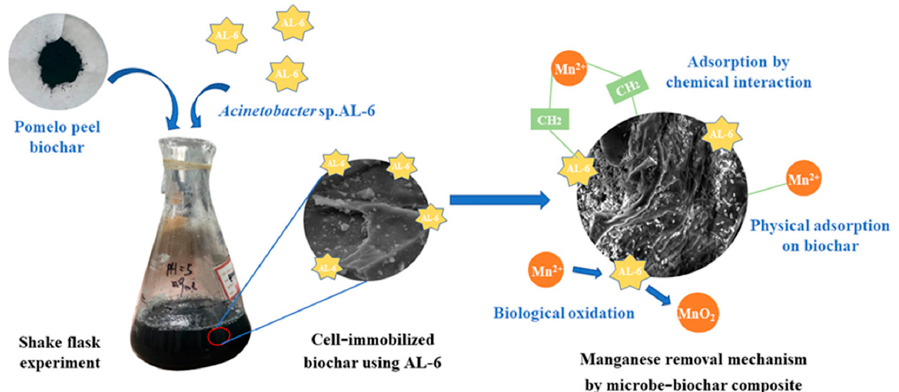
Figure 3. Mechanisms of synergies between Acinetobacter sp . AL-6 and pomelo peel biochar in a hybrid process. Reprinted with permission from Ref. [158].